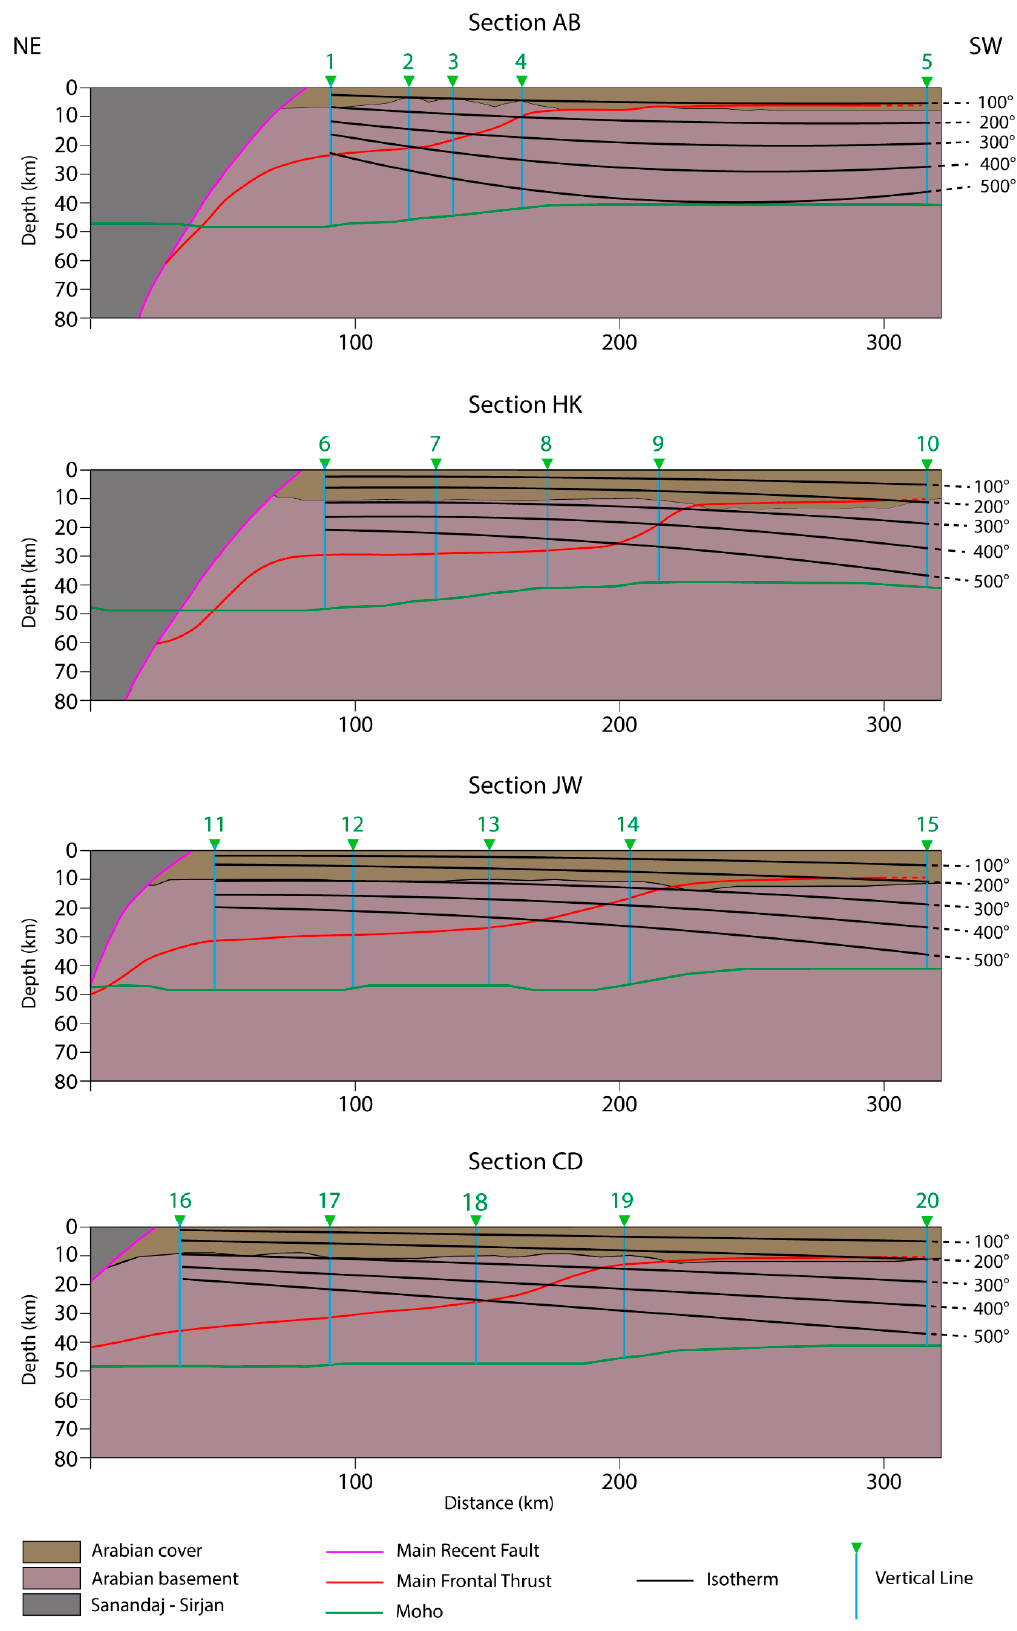
Figure 8. Isotherms for the 100-500 °C temperature range (100 °C steps) calculated using a second-order power-law polynomial interpolation for cross-sections AB, KH, WJ, and DC (located in Figure 5).